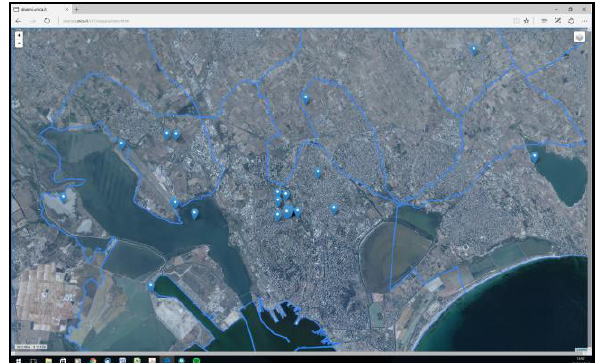
Figure 11. The WebGIS with the "Unità architettonica” (Architectural